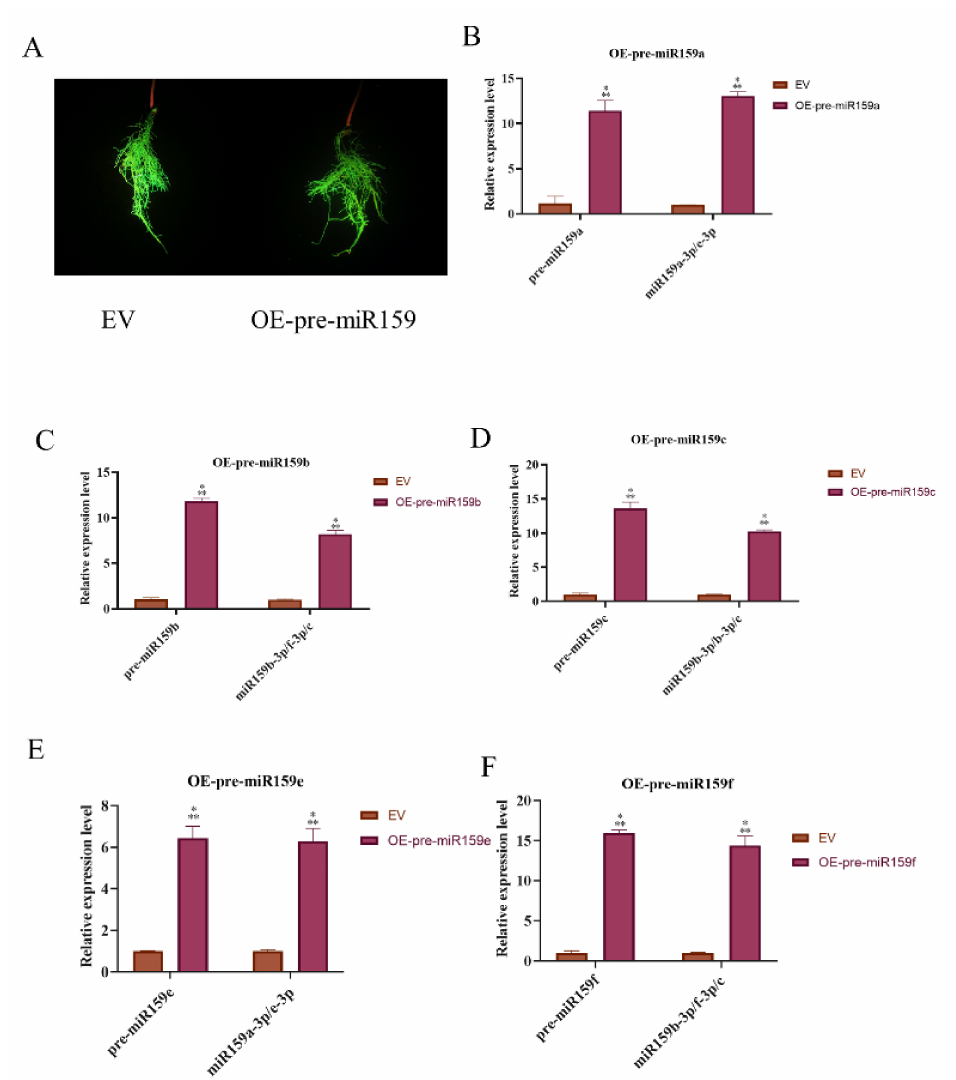
Figure 4. The expression level of miR159 in transgenic pre-miR159 overexpressing soybean hairy roots. ( A ) Soybean hairy roots with strong GFP signal, EV, hairy roots of empty vector, OE-pre-miR159 and miR159 overexpressing soybean hairy roots. ( B – F ) The relative expression level of precursors and mature sequences of miR159 detected by qRT–PCR. Expression levels of miR159 in OE were relative to EV with soybean U6 as the internal reference gene. t -test was applied to compare differences between OE and EV hairy roots. ***, significant difference found at p < 0.001 level. Error bars represent the standard deviation from the